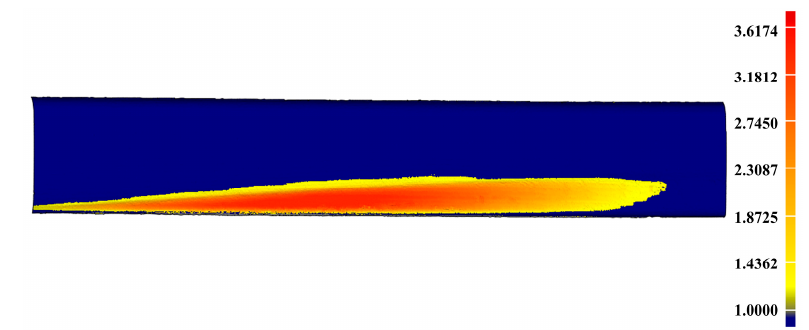
Figure 21. The depth-difference between the reference PCM and the scratch-surface PCM on the practical damaged rail.